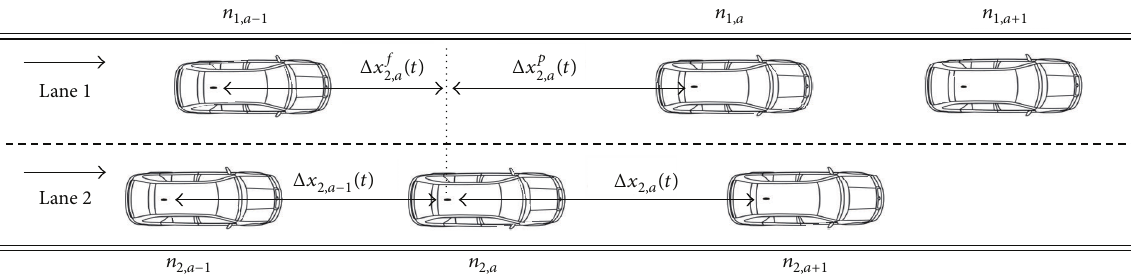
𝑓 (𝑡) are the headway distances from the 2,𝑎